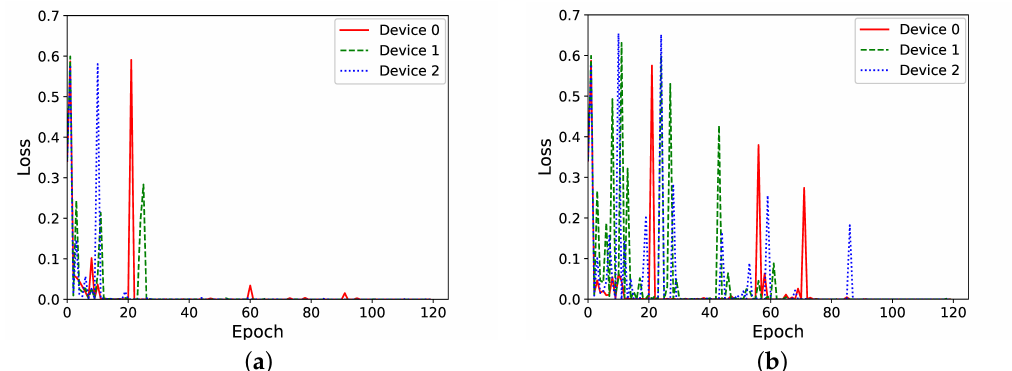
Figure 6. Loss vs. epochs during training for frequent and infrequent federated learning rounds. ( a ) Federated learning round performed every 2 epochs. ( b ) Federated learning round performed every 30 epochs.